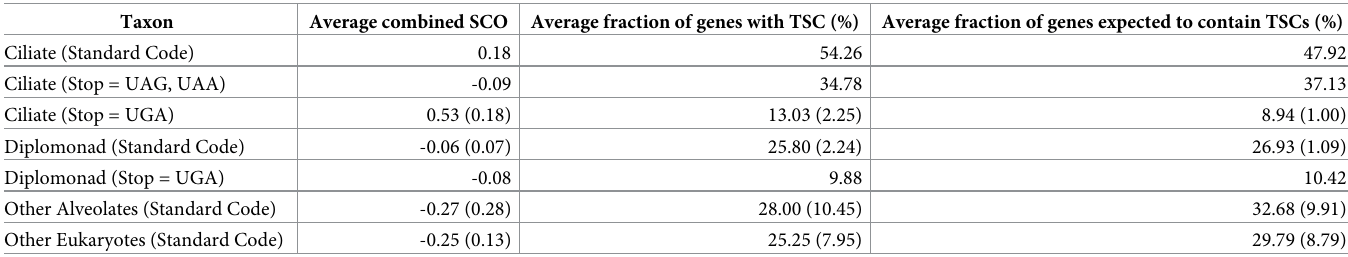
Table 2. Average combined SCO scores, fraction of genes containing TSCs and fraction of genes expected to contain TSCs, across groups of species 1 .